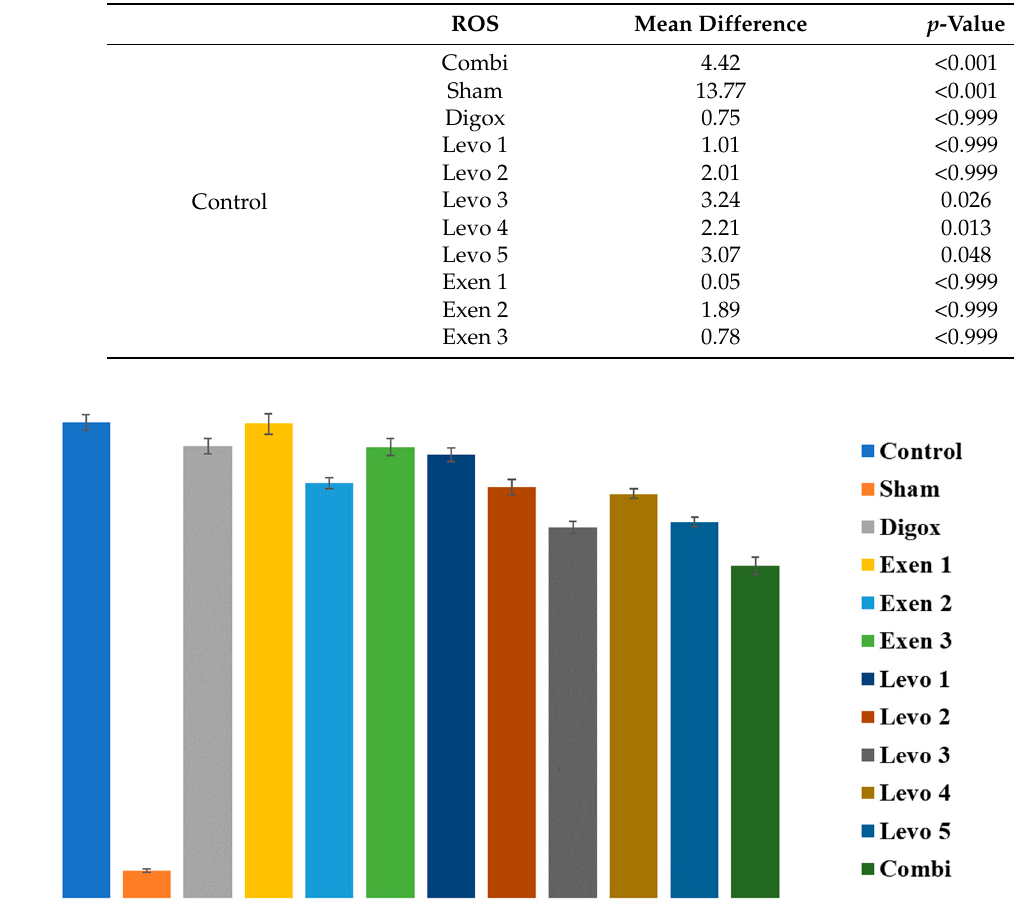
Figure 18. Differences in Reactive Oxygen Species across groups.